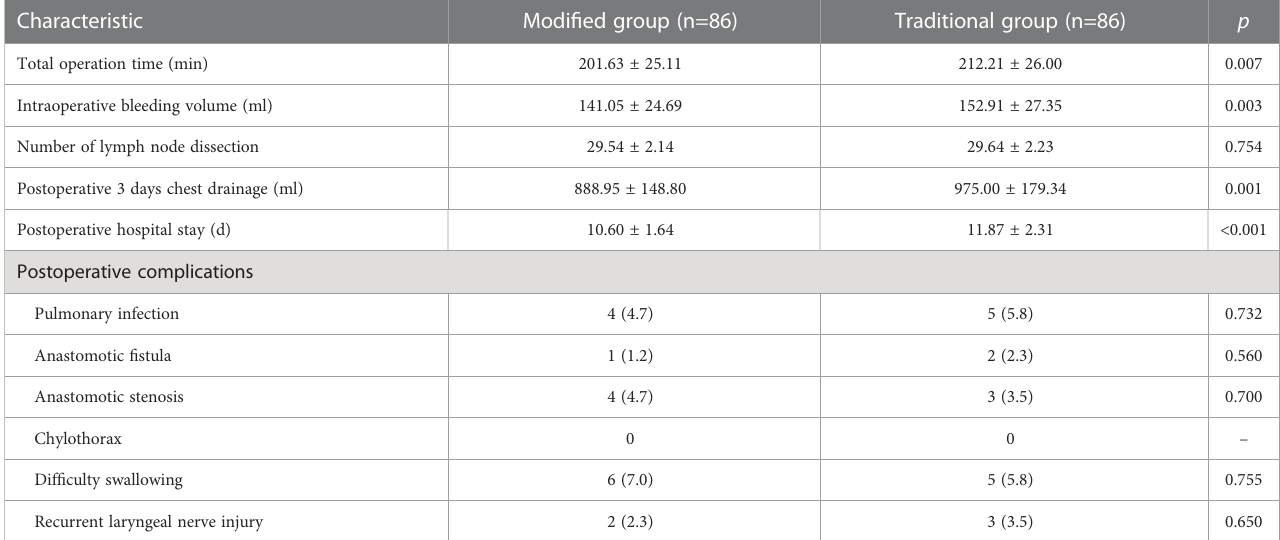
TABLE 2 Surgical data of patients [cases (%)/ (cid:1) x ± s ].